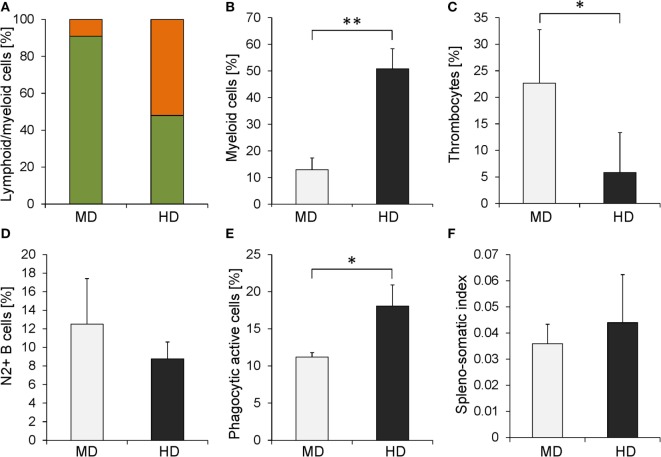
Comparison of several immunological parameters between whitefish kept at moderate density (MD) (gray bars) and that kept at high density (HD) (black bars). (A) The ratio between lymphocytes (green filling) and myeloid cells (orange filling) was determined based on size and granularity using flow cytometry. Specific MAbs allowed the quantification of the proportion of (B) myeloid cells, (C) thrombocytes, and (D) light-chain-positive B cells. (E) The phagocytic activity of blood leukocytes was assessed using latex bead-based assays. (F) SSI was determined for MD and HD individuals. Graphs represent the mean values + stocking density (error bars). Significant changes calculated using one-way analysis of variance are marked with (*) for p ≤ 0.05 and (**) for p ≤ 0.01.